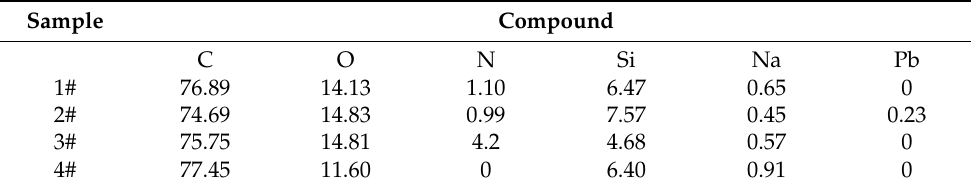
Table 7. Comparison of the elements before and after ablation (%).